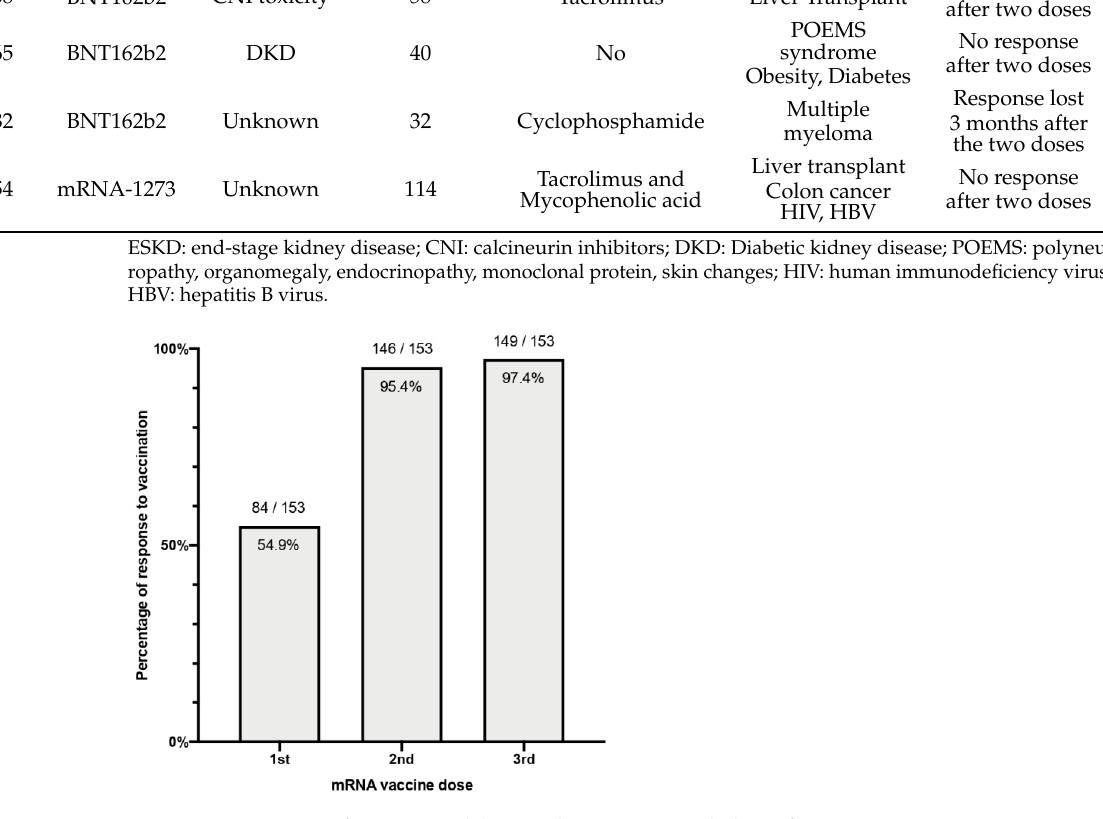
Figure 1. Percentage of patients with humoral response to each dose of any SARS-CoV-2 mRNA vaccine. Table 1. Clinical characteristics of non-responders to three doses of SARS-CoV-2 mRNA vaccina- tion.